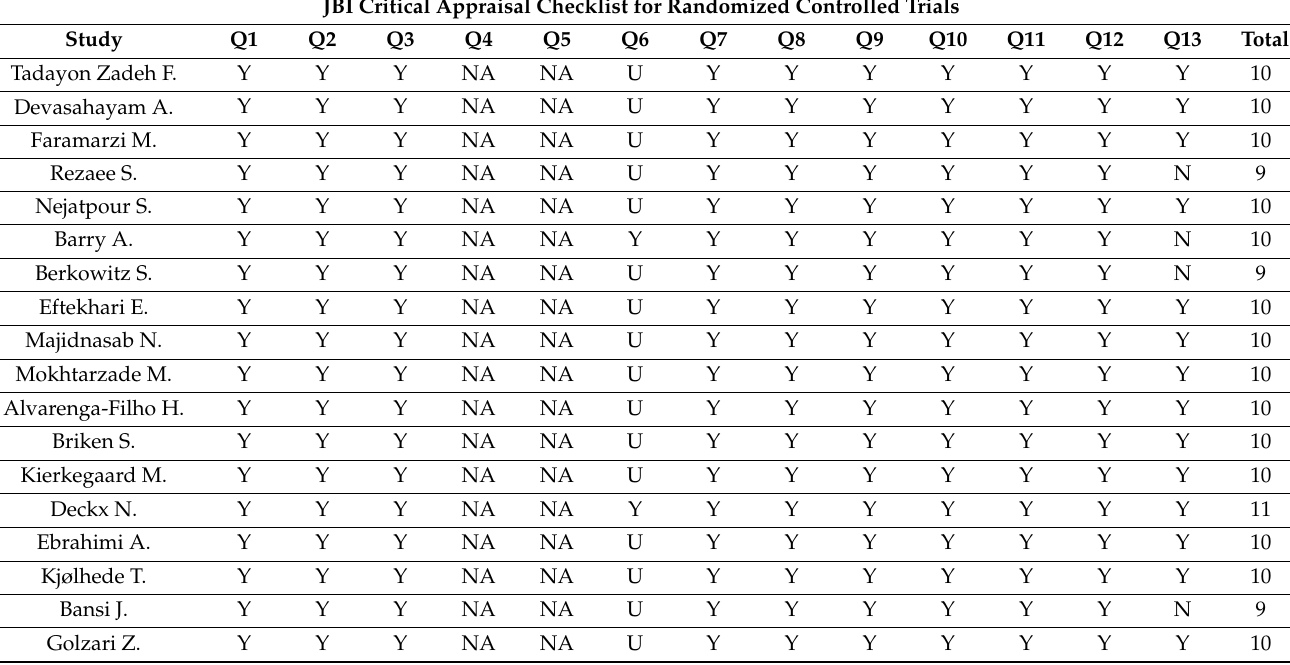
Table 1. JBI tool for assessing